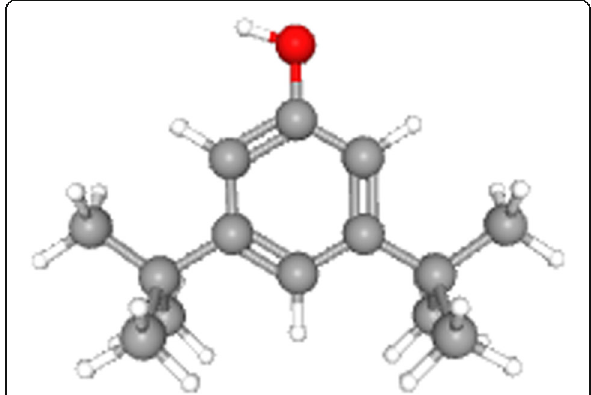
Fig. 6 3D representation of Phenol, 3,5-di-tert-butyl